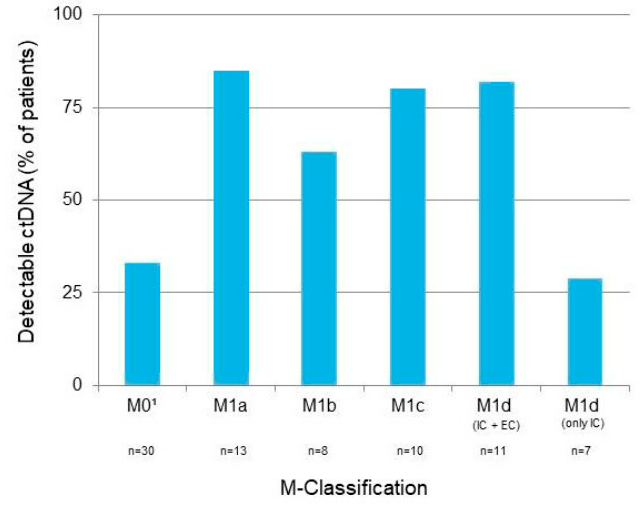
Figure 2. Metastasis staging according to the AJCC 8.0 M classification [17] at the time of the first ctDNA sample collection in patients with detectable and undetectable ctDNA. 1 M0, no distant metastasis; M1a, skin, soft tissue, and/or non-regional lymph nodes; M1b, pulmonary metastasis, with or without lesions from M1a; M1c, metastasis in other non-CNS visceral sites, with or without lesions from M1a and M1b; M1d, metastasis of the CNS, with (IC + EC) or without (IC only) M1a, M1b, and M1c.